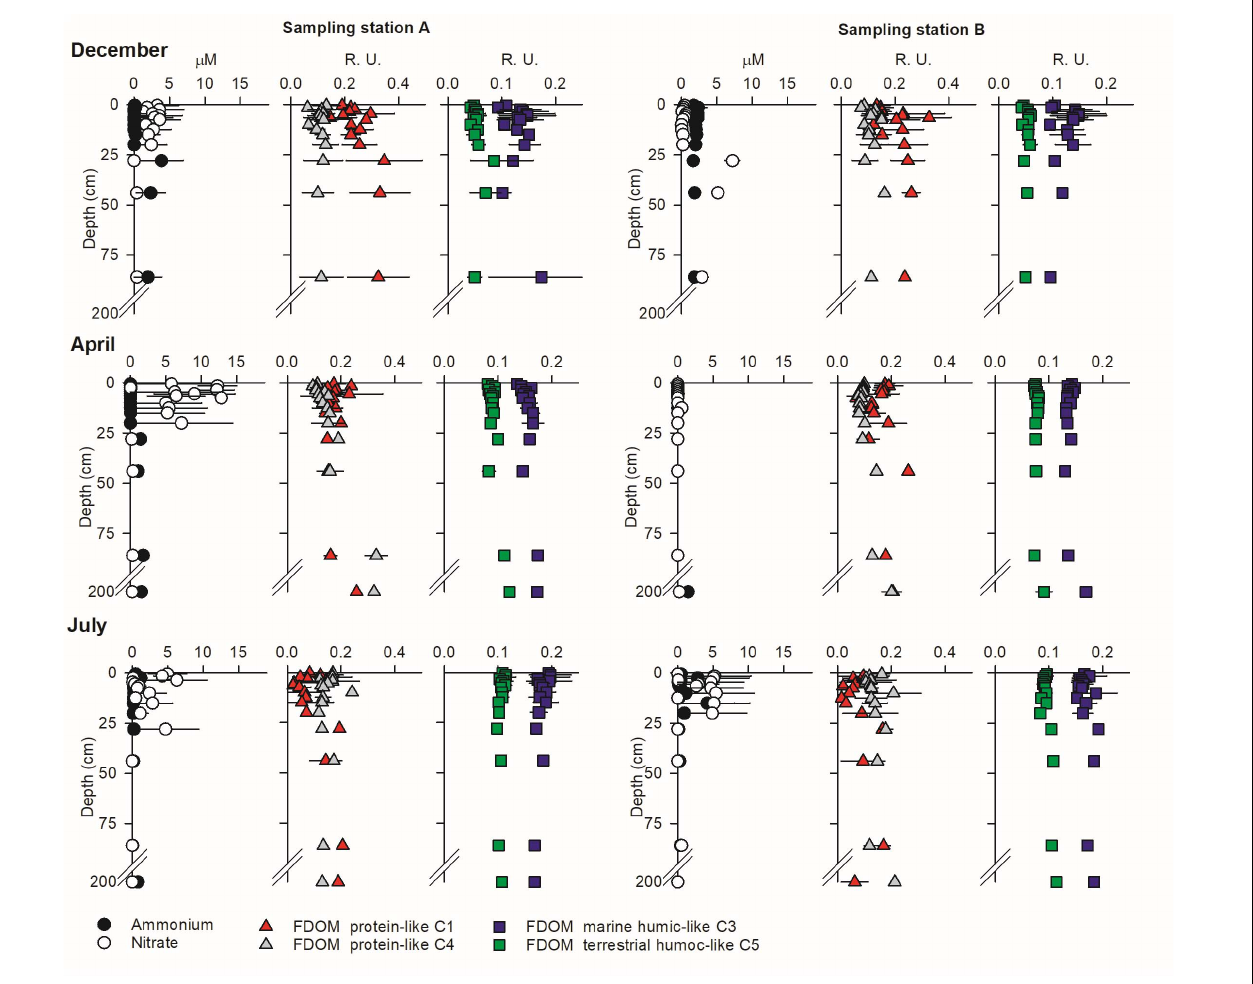
FIGURE 9 | High-resolution vertical porewater profiles of NH 4 + , NO 3 − , and FDOM components during the peak of discharge in stations A and B during December 2009 and April and July 2010. Porewater profiles correspond to the average of those obtained during two consecutive tidal cycles with piezometers and porewater